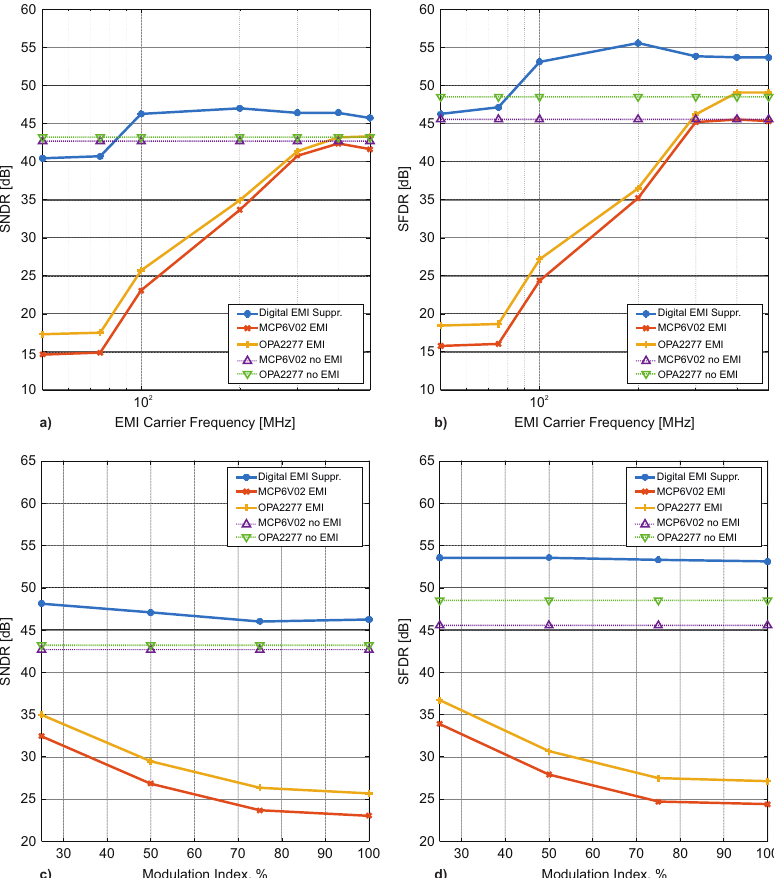
Figure 14. Measured SNDR and SFDR of the waveforms obtained by the proposed EMI suppression technique with α = 0.445 (blue line, * marker), at the MCP6V02 output (red line, x marker), at the OPA2277 output (yellow line, + marker) in the presence of AM modulated EMI with carrier frequency ranging from 50 MHz to 500 MHz, square wave modulating signal with modulation index rangin from 25% to 100%, for an EMI incident power of 0 dBm: ( a ) SNDR vs. carrier frequency; ( b ) SFDR vs. carrier frequency; ( c ) SNDR vs. modulation index; ( d ) SFDR vs. modulation